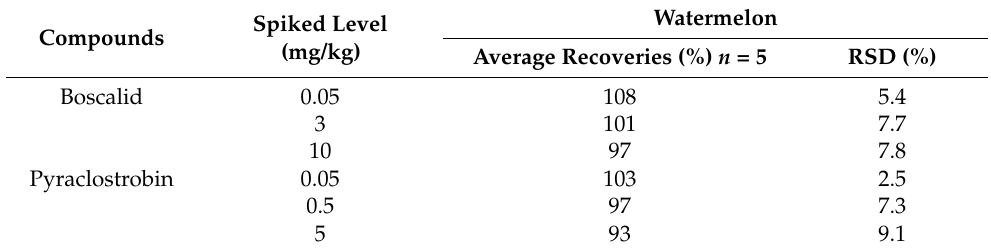
Table 1. Recoveries ( n = 5) of boscalid and pyraclostrobin in different matrices. Compounds